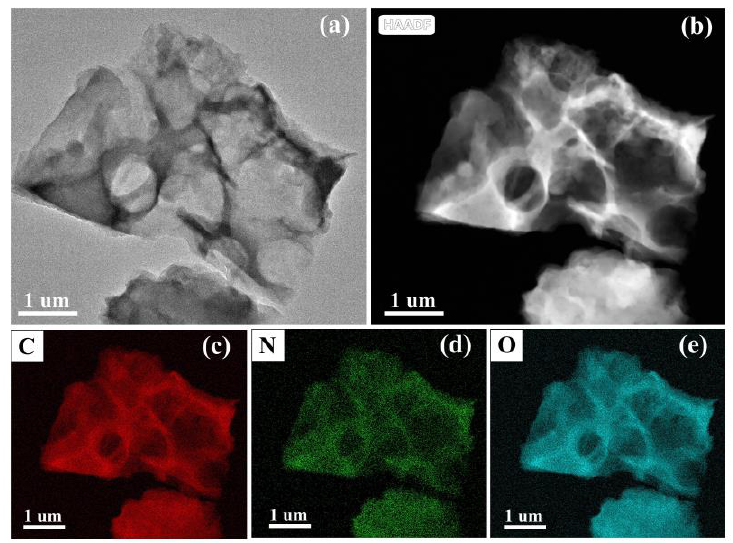
Figure 5. ( a ) TEM and ( b – e ) EDS images of C OCLP-4.5 .